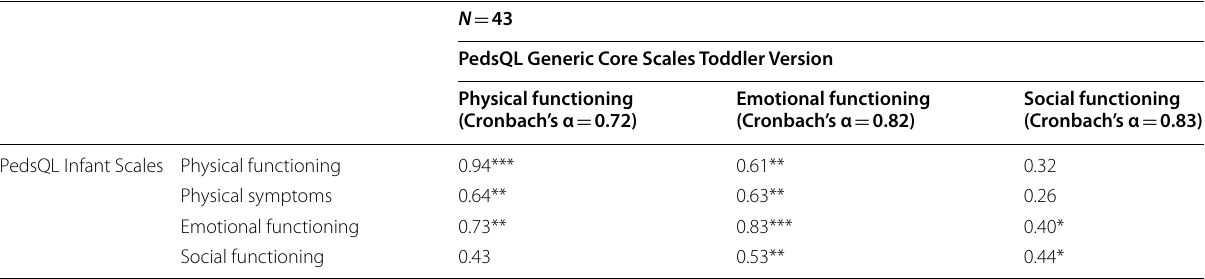
Correlation coefficients divided by Cronbach’s α of each subscale on PedsQL Generic Core Scales Toddler Version calculated in the present study